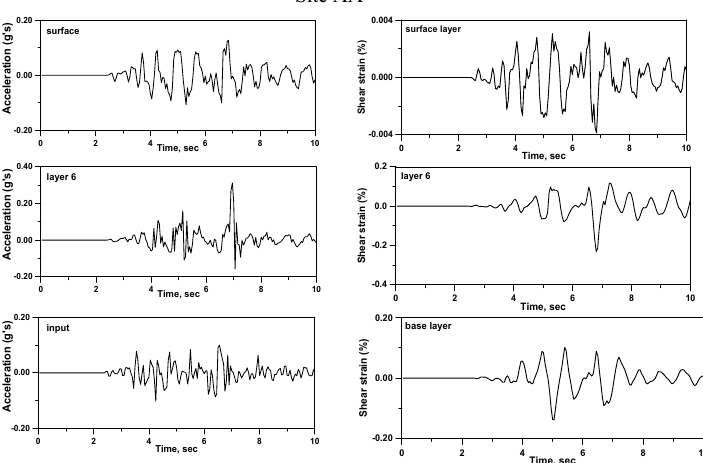
Fig. 11. Acceleration (left column) and strain (right column) time histories at different depths in the soil column at investigated site AA 0 .